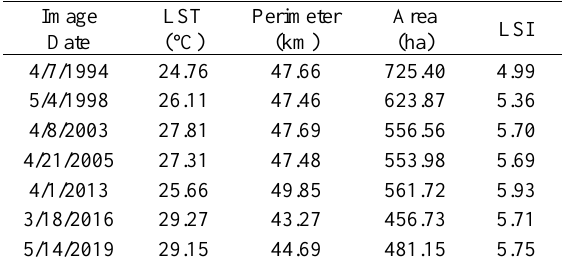
Table 4. Spatial characteristics of Iloilo River and adjacent